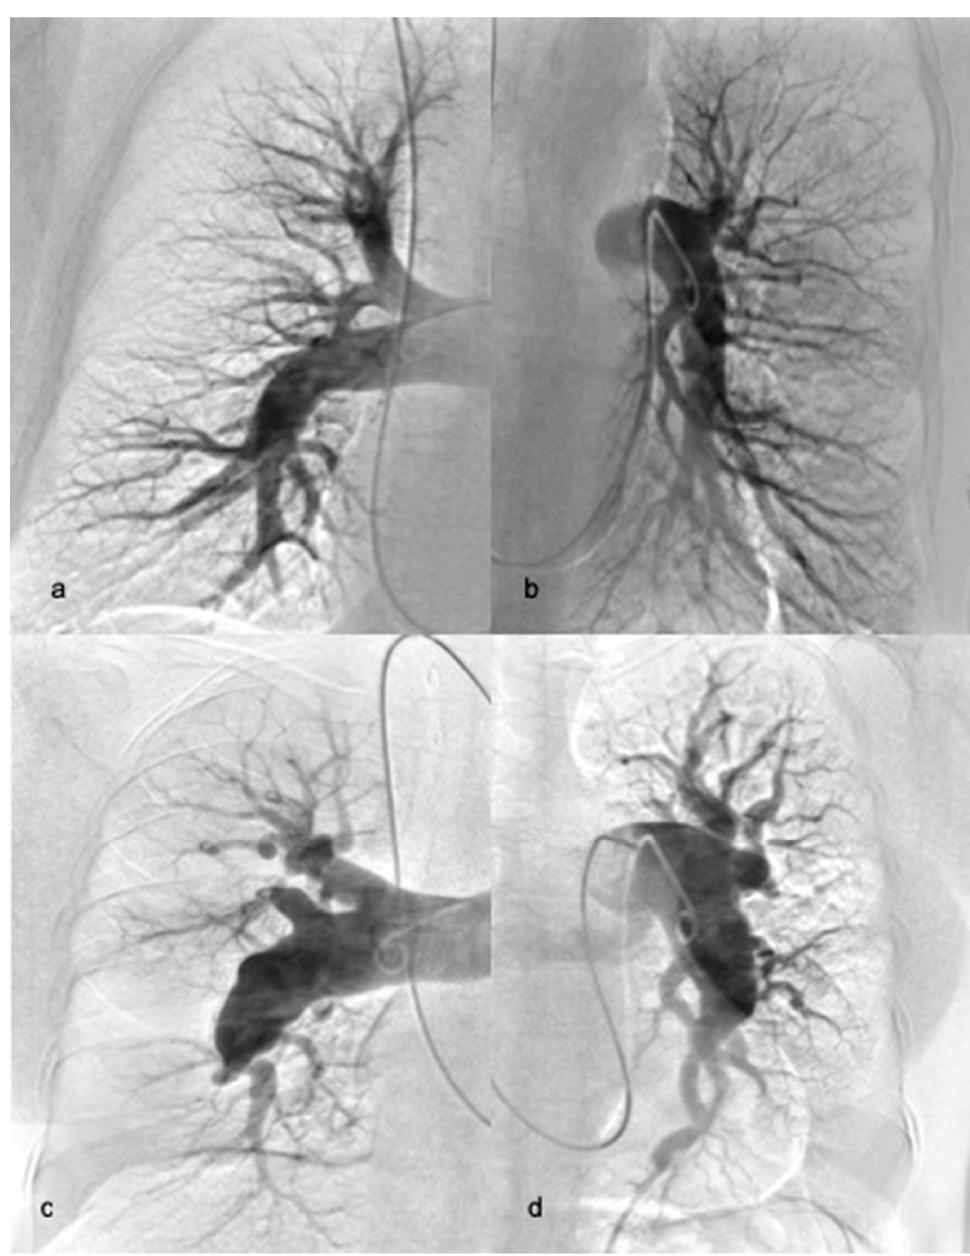
Figure 1. Example of right ( a ) and left ( b ) pulmonary angiography of patient with distal-type chronic thromboembolic pulmonary hypertension (CTEPH) and right ( c ) and left ( d ) pulmonary angiography of patient with proximal-type CTEPH.